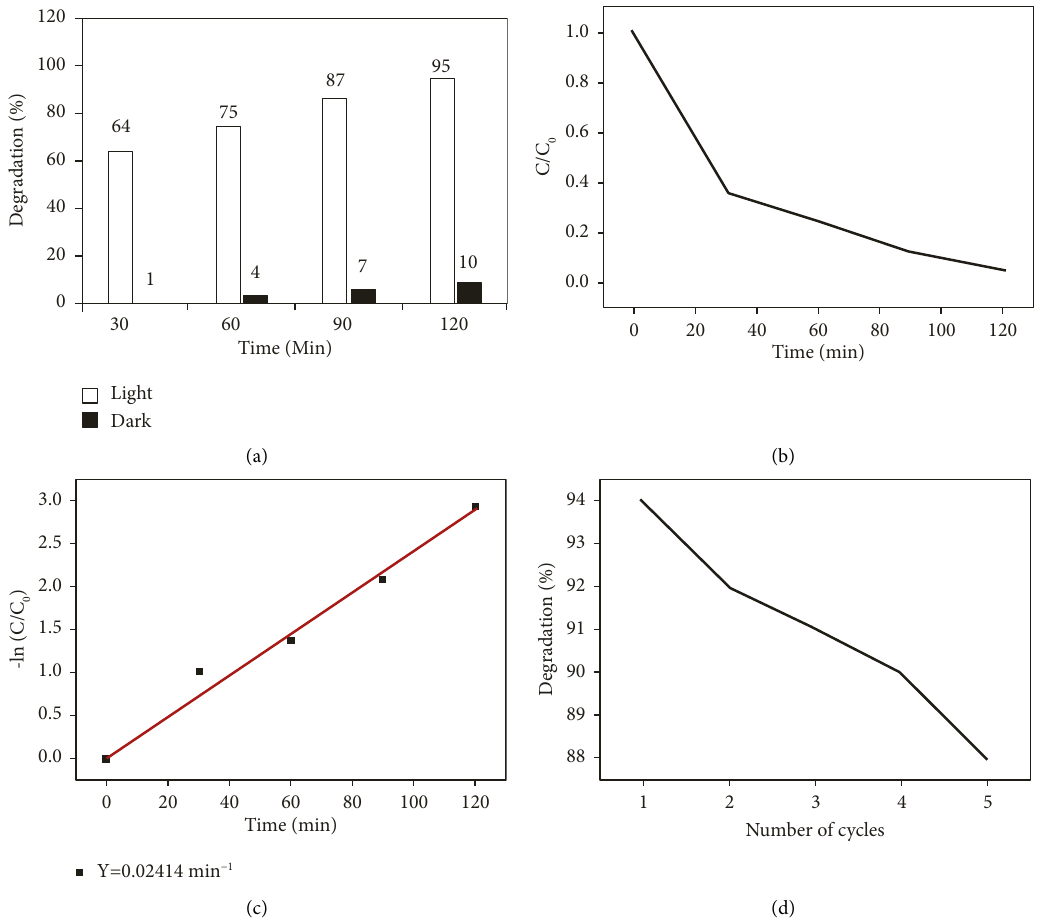
Figure 5: (a) Photocatalytic MB dye degradation efficiency, (b) C/C0, (c) ln C/C0 vs time, and the (d) reusability study of Bi-TiO nanoparticle.